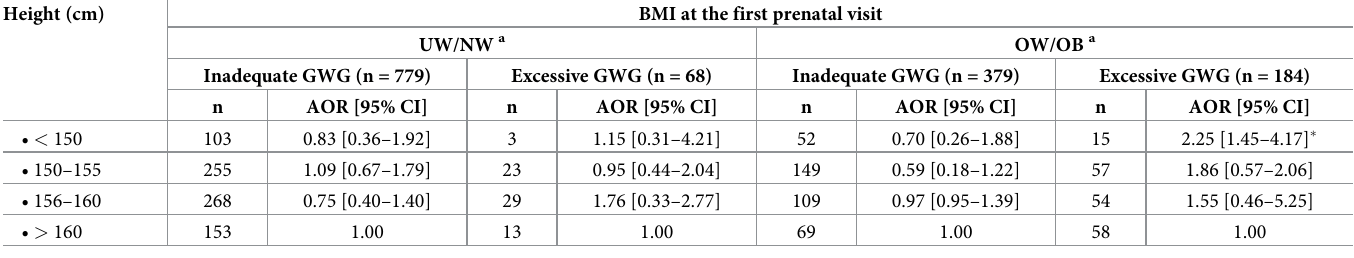
Table 5. Adjusted odds ratio (OR) and 95% confidence intervals (95% CI) for associations between height and gestational diabetes mellitus (GDM) stratified by BMI at the prenatal visit. Height